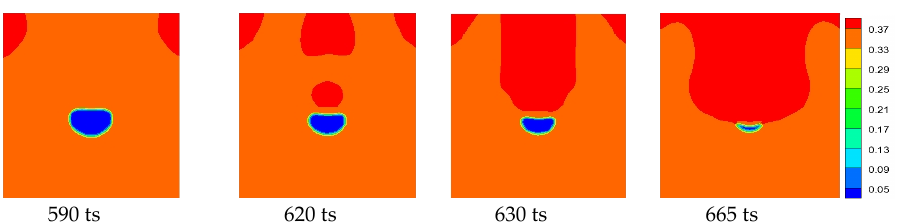
Figure 3. Density field of the LBM simulation: λ = 2.5, R 0 = 80 lu.